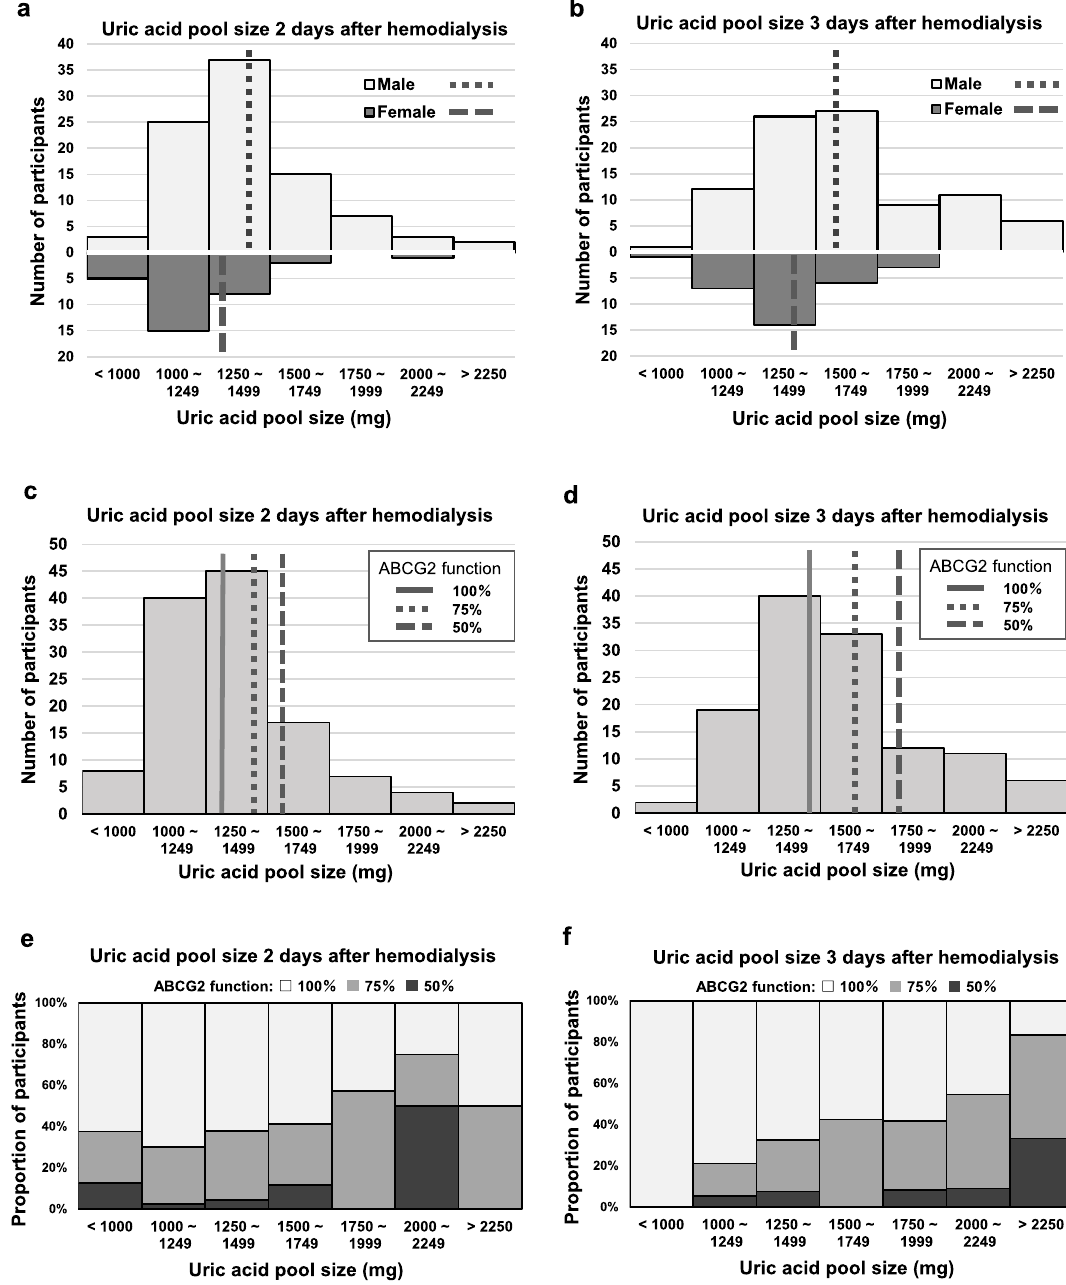
Figure 3. ( a ) White and gray histograms represent the uric acid pool after a 2-day interval in male and female participants, respectively. Dotted and a dashed lines represent the mean uric acid pool for males (mean ± standard deviation: 1410 ± 305 mg) and females (1223 ± 242 mg) after 2-day interval. ( b ) White and gray histograms represent the uric acid pool after a 3-day interval in male and female participants, respectively. Dotted and dashed lines represent the mean uric acid pool for males (1619 ± 365 mg) and females (1405 ± 245 mg) after a 3-day interval. ( c ) Uric acid pool size after a 2-day hemodialysis interval was 1363 ± 305 mg in overall participants. Solid, dotted, and dashed lines represent the mean of uric acid pool size in ABCG2 100, 75 and 50% functional groups, respectively [ABCG2 100% function (solid line), 1322 ± 283 mg; 75% function (dotted line), 1410 ± 314 mg; 50% function (dashed line), 1510 ± 418 mg (P = 0.129)]. ( d ) Uric acid pool size after a 3-day hemodialysis interval. The mean and standard deviation of the uric acid pool size in overall participants was 1565 ± 350 mg. Solid, dotted, and dashed lines represent the mean of the uric acid pool size in ABCG2 100, 75 and 50% functional groups, respectively [ABCG2 100% function (solid line), 1492 ± 313 mg; 75% function (dotted line), 1657 ± 337 mg; 50% function (dashed line), 1815 ± 545 mg (P = 0.006)]. ( e ) Relationship between ABCG2 dysfunction (75% and 50%) and uric acid pool size after a 2-day hemodialysis interval (P for trend = 0.071). ( f ) Relationship between ABCG2 dysfunction (75% and 50%) and uric acid pool size after a 3-day hemodialysis interval (P for trend =